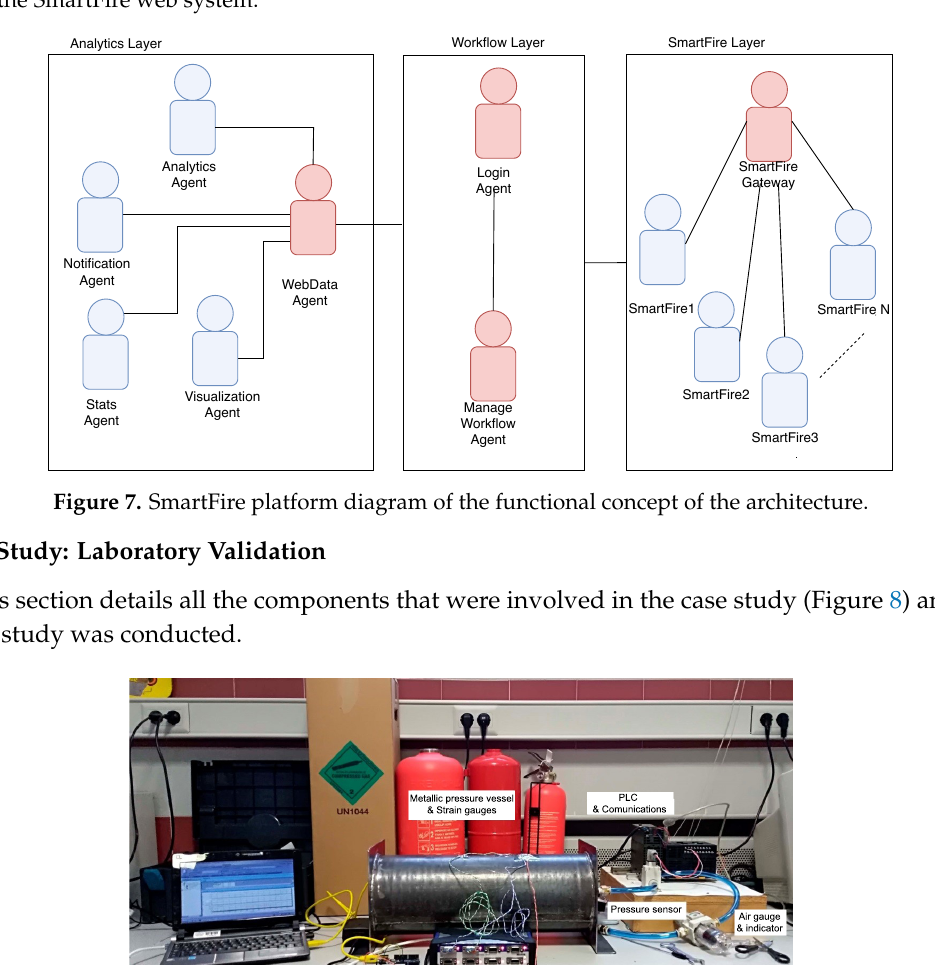
Figure 6. Visualization of the pressure values of the different extinguishers deployed in the building via the SmartFire web system.